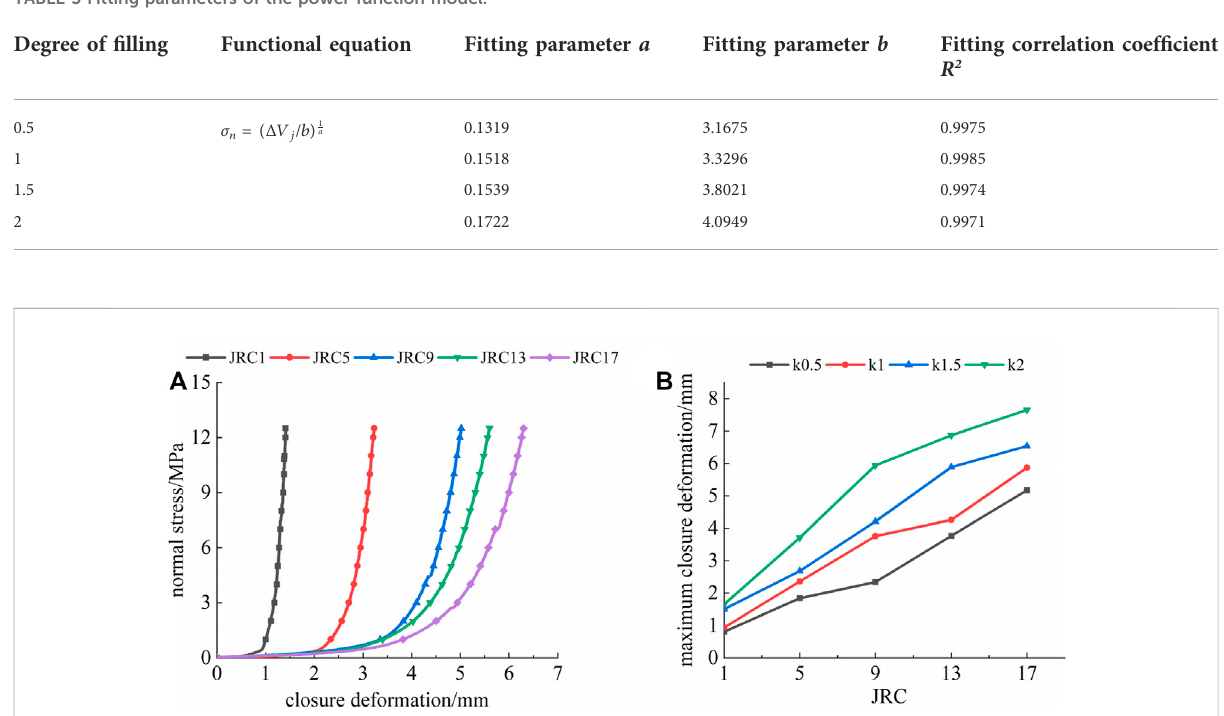
TABLE 5 Fitting parameters of the power function model.